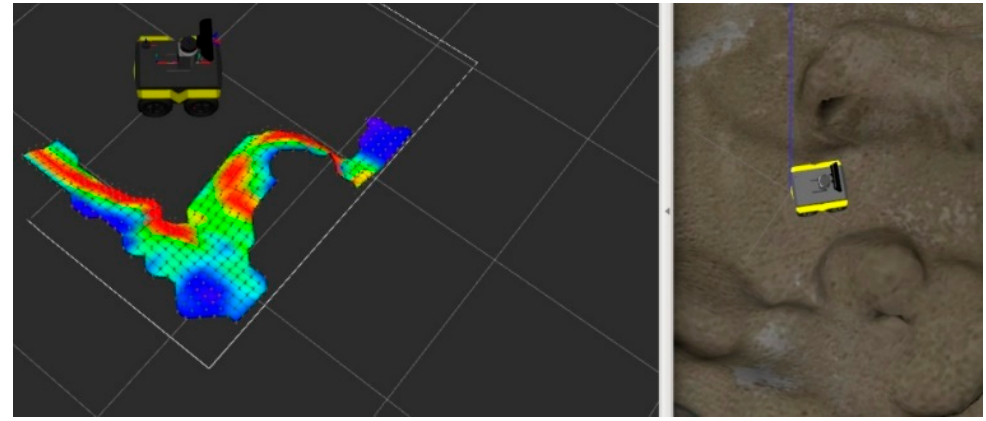
Figure 11. Robot operating system (ROS) simulation environment indication and mapping results.